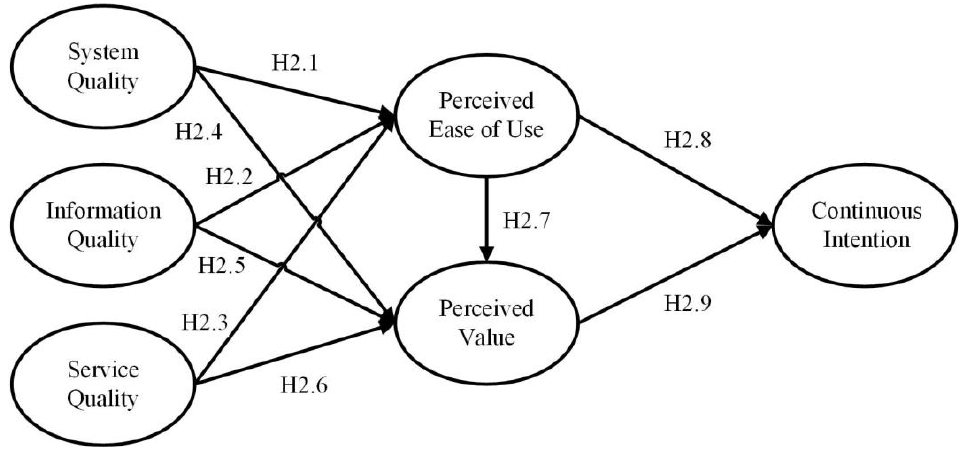
Figure 2. Research Model II (TAM-IS Success Integrated Model).